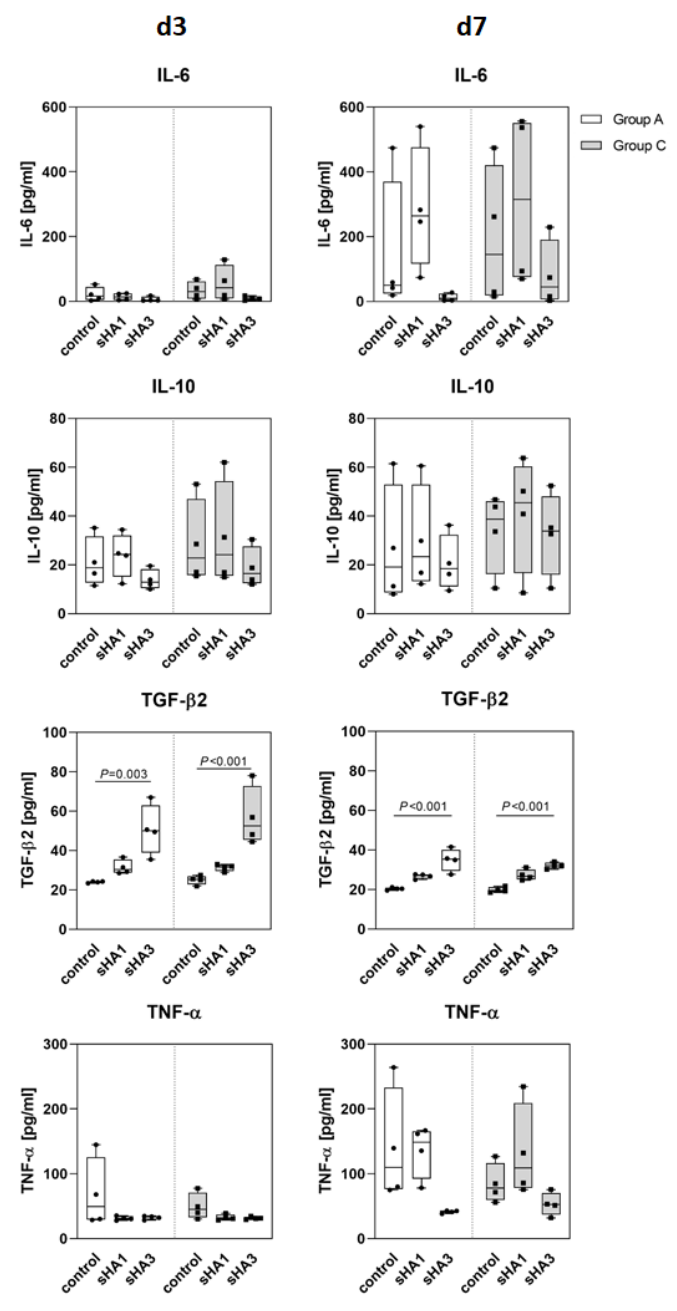
Figure 6. Impact of sHA1 and sHA3 on cytokine concentrations in PBMC of arthritis (group A) and Charcot patients (group C). PBMC were treated with M-CSF/RANKL and sHA derivatives. Cell culture supernatant was collected on day 3 and 7 for cytokine quantification by ELISA (n = 4). Data are given as median with interquartile range and min/max values, statistical analyses were performed using ANOVA and Tukey post-hoc